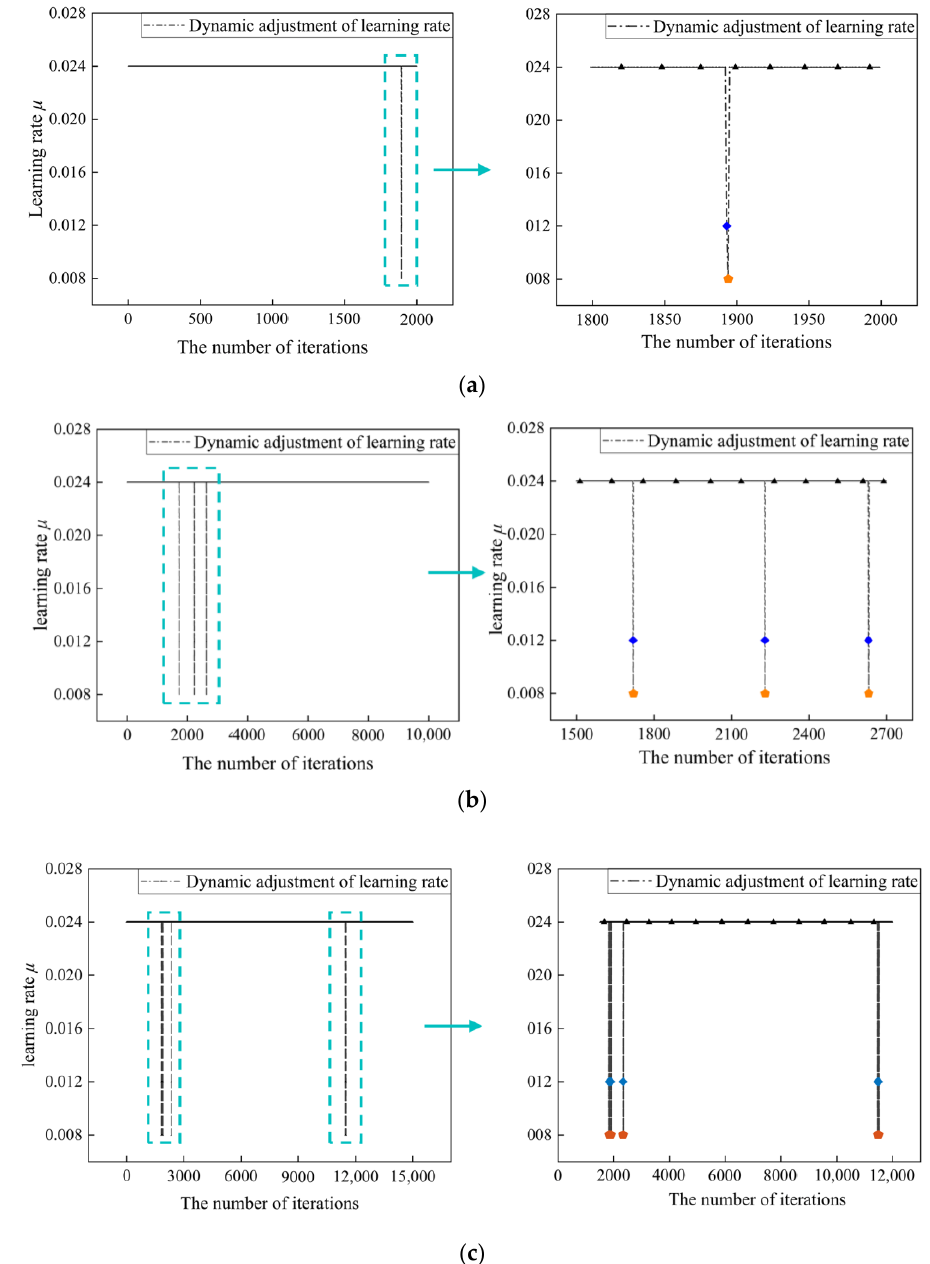
Figure 9. Dynamic change of the learning rate in the presented model during training: ( a ) the number of iteration steps K of the models is 2000; ( b ) the number of iteration steps K of the models is 10,000; ( c ) the number of iteration steps K of the models is 15,000.